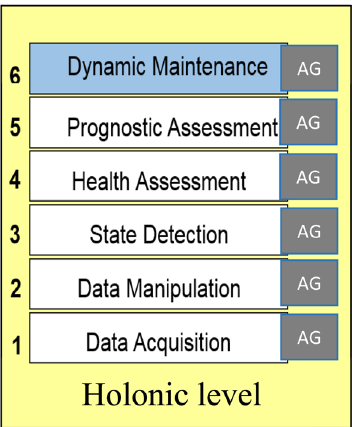
Fig. 10 Holonic level